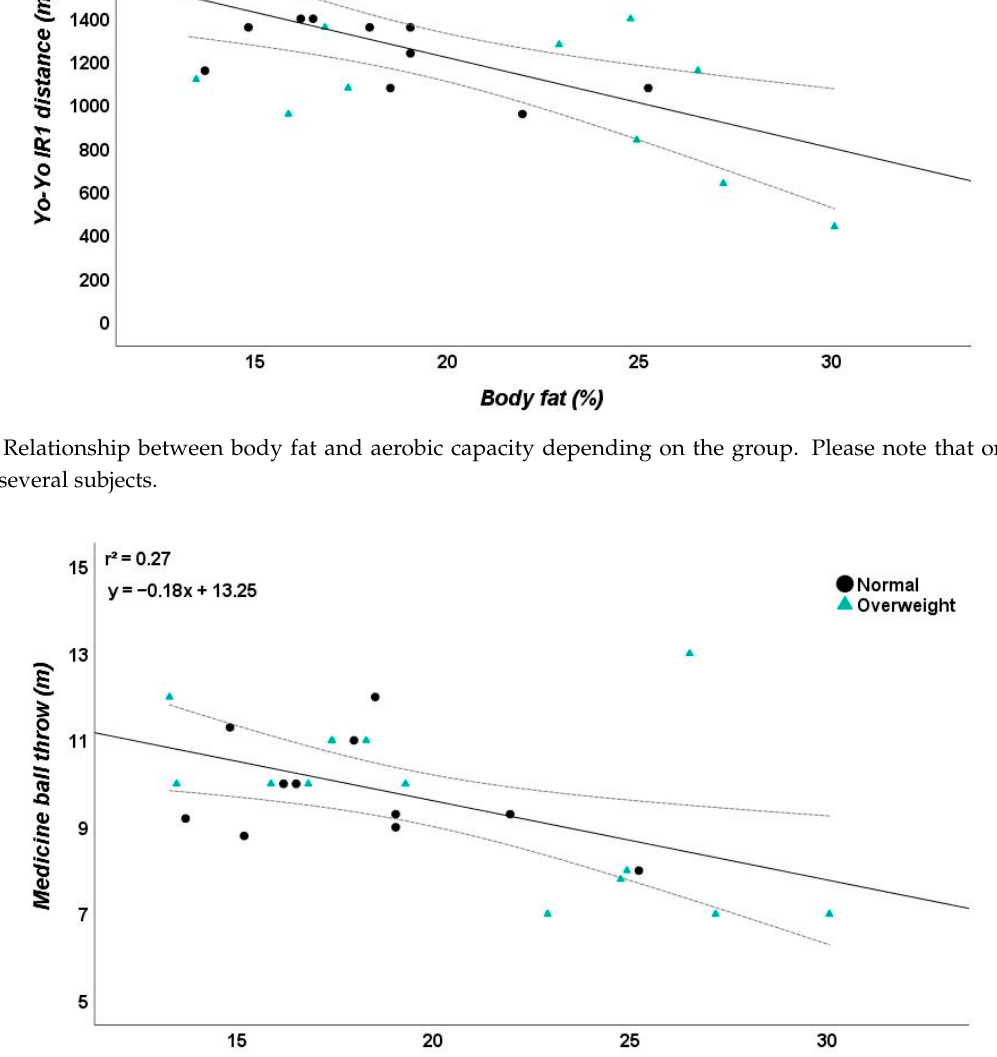
Figure 3. Relationship between body fat and medicine ball throw distance depending on the group. Please note that one dot can represent several subjects.